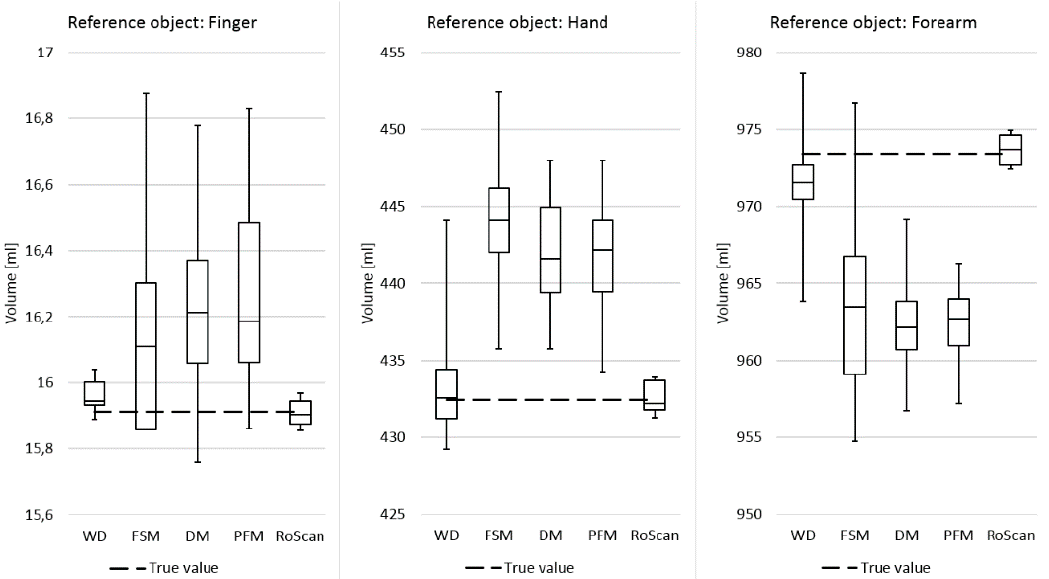
Figure 15. The RoScan compared with the circumferential techniques and the water displacement method implemented in a reference object having a known volume: the RoScan displayed the most accurate and repeatable performance [12].